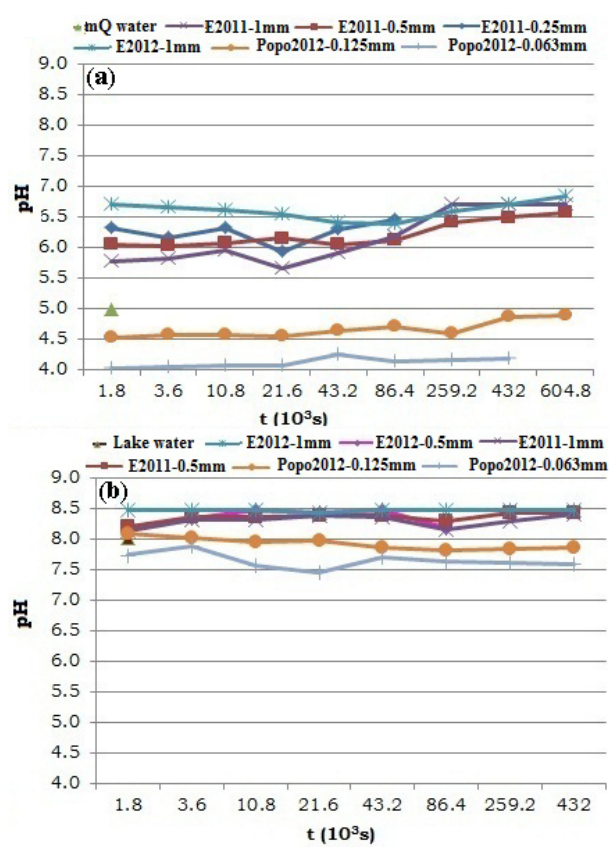
Figure 6. NH 3 –NH + variation of ash leachates in (a) mQ; and 4 (b) lake water for variable stirring times and different grain sizes. The NH 3 content of mQ and lake water is indicated for compari-